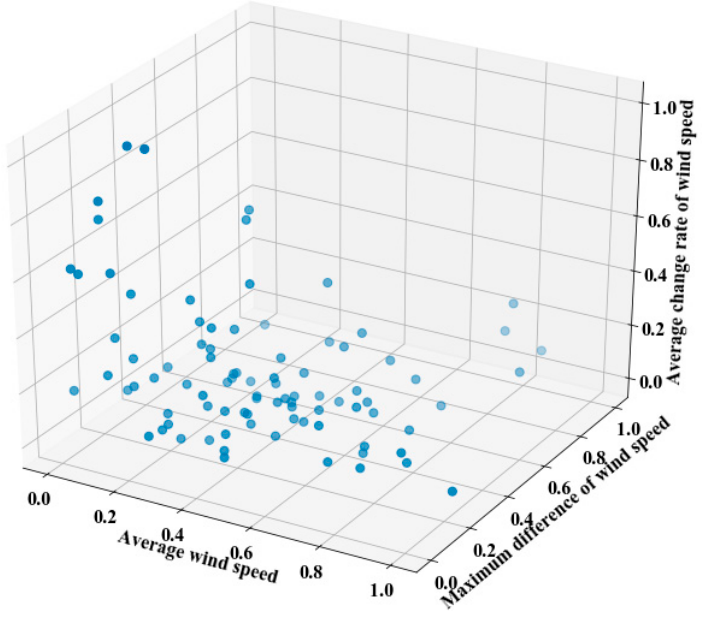
Figure 5. The scatter diagram of the historical days and the forecasted day in three dimensions. Secondly, the parameters eps and Minpts of DBSCAN are iterated in equal steps. In this paper, parameters that can divide all sample points evenly into two clusters are used, and historical days in the cluster which the forecasted day is in is selected as similar days. Figure 6 is the scatter diagram of the historical days and the forecasted day when parameter eps = 0.147 and Minpts = 9. The blue star point represents the forecasted day, the blue circle points represent the similar days, and the red ‘ + ’ points represent the unsimilar